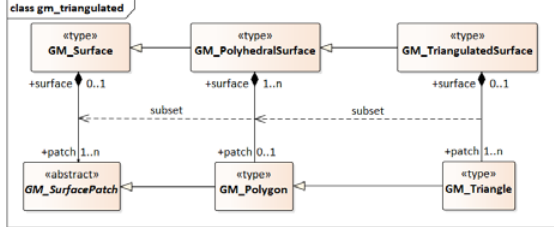
Figure 3. Relationship of GM TriangulatedSurface and other types in ISO 19107